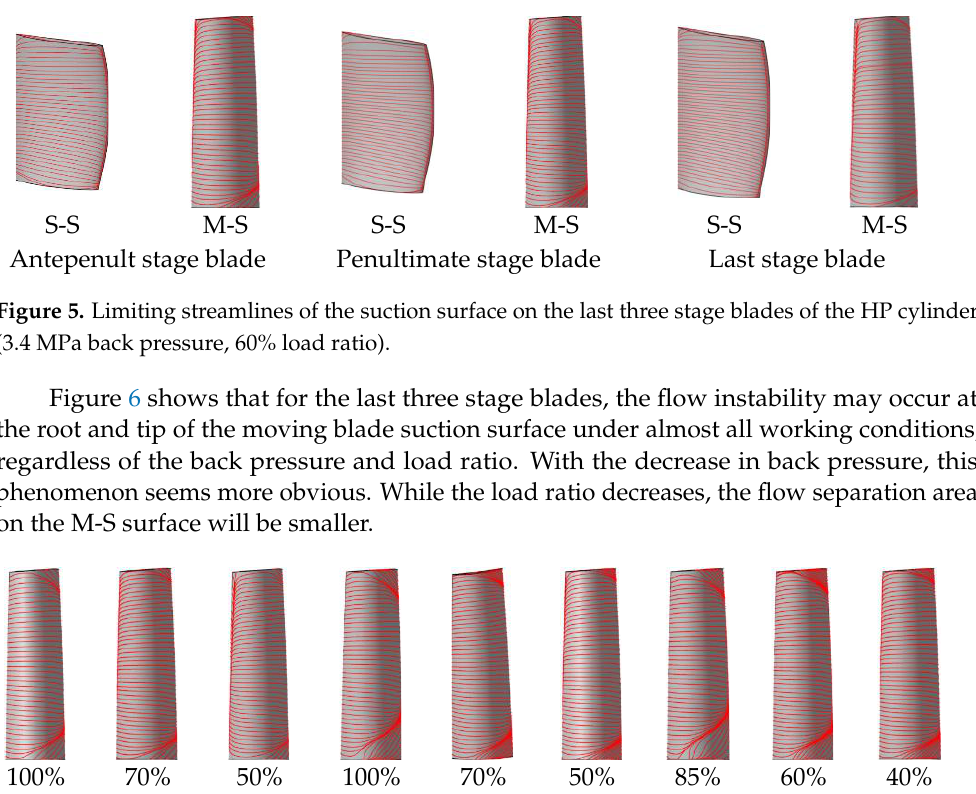
Figure 4. Limiting streamlines of the pressure surface on the last three stage blades of the HP cylin- der (3.4 MPa back pressure, 60% load ratio).